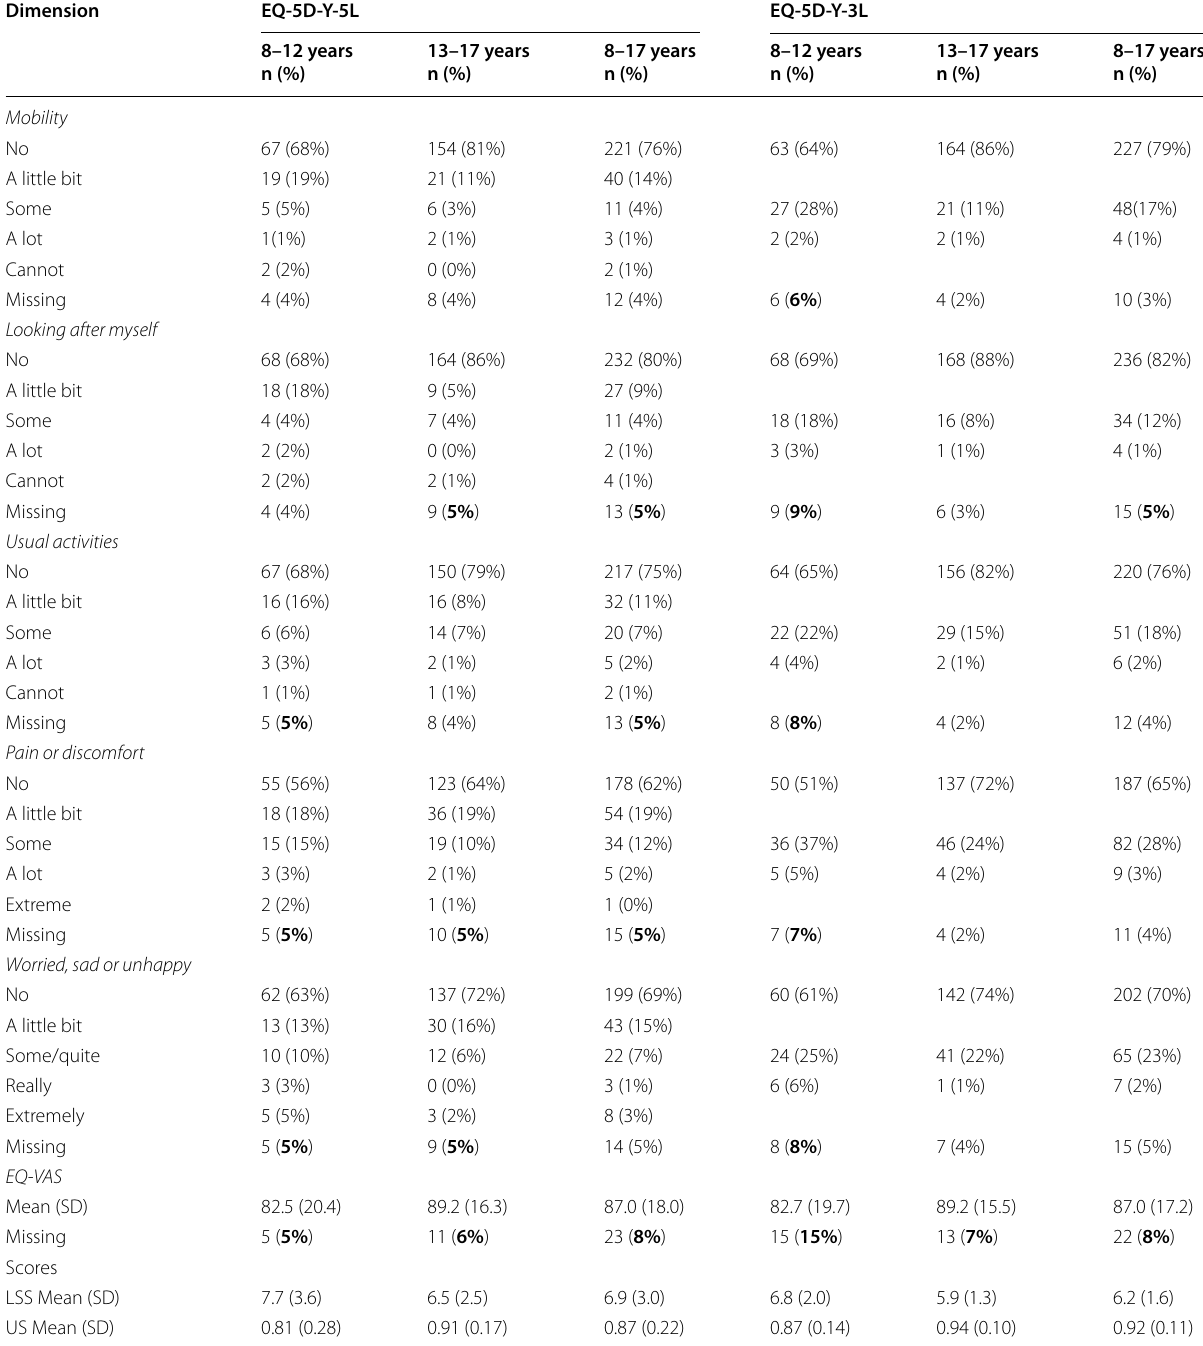
Bold indicates proportion of missing responses